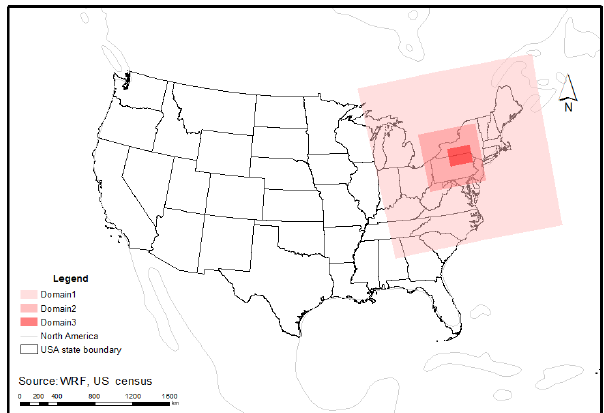
Figure 3. Map of study area shows three nested domains of WRF. extends into southeastern New